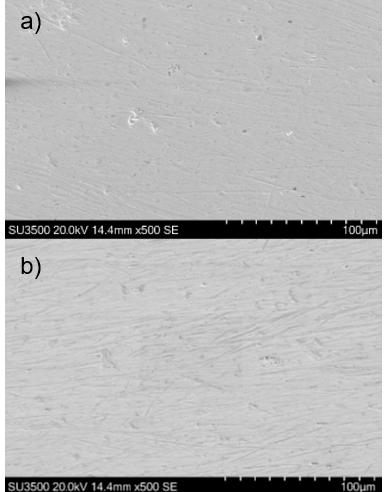
Figure 15. SEM picture before ( a ) and after ( b ) Stream Finishing process optimization.